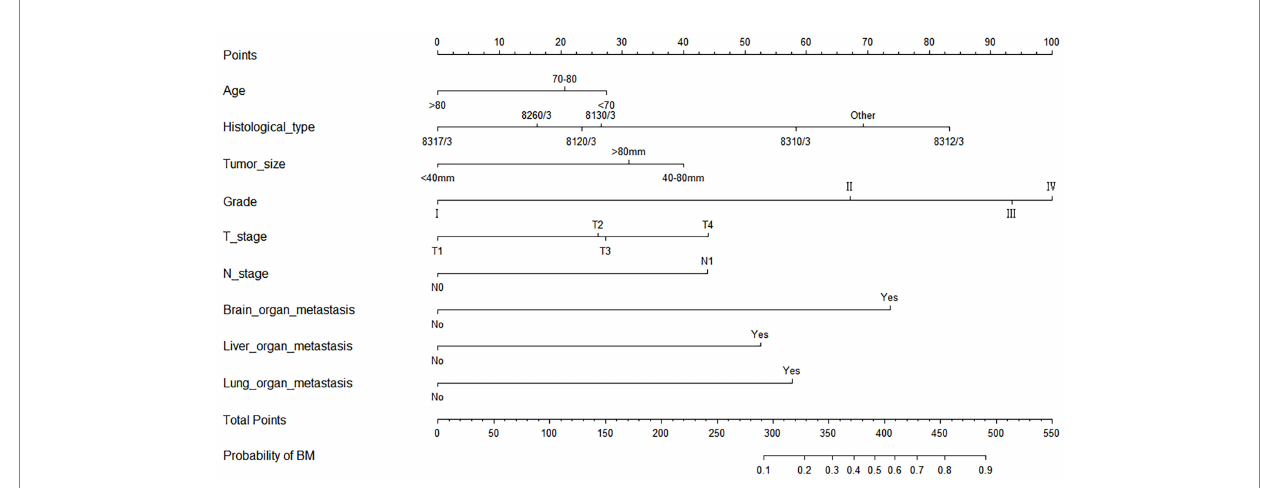
FIGURE 3 Diagnostic nomogram for quantifying the probability of bone metastasis (BM) in elderly kidney cancer (KC) patients.